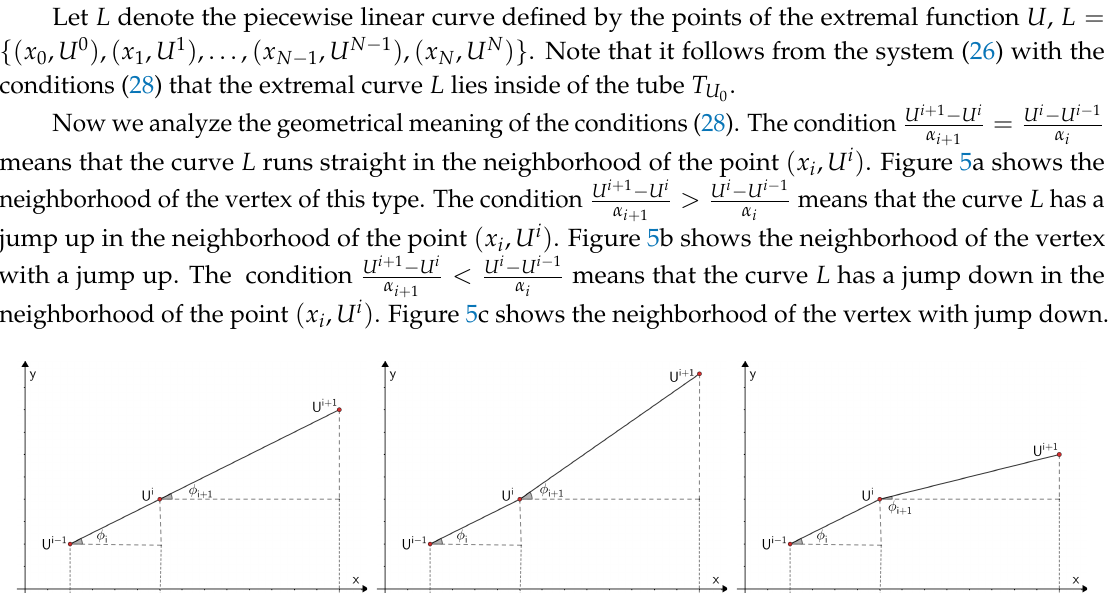
0 and corresponding curve C 0 (blue dashed line).